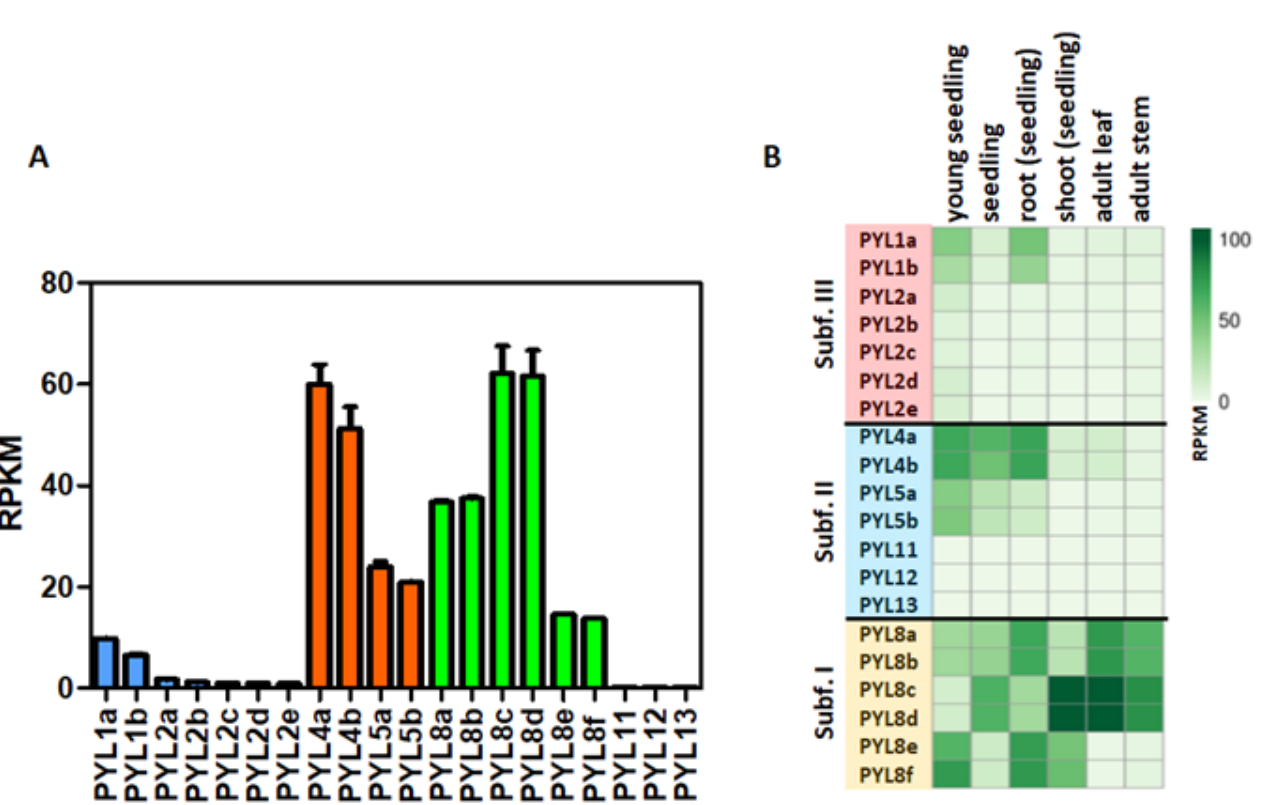
Figure 4. Gene structure of PYL genes in quinoa. The yellow and blue rectangles represent the CDSs and UTRs, respectively, and the black lines represents introns. The lengths of the CDSs, UTRs and introns for each PYL gene are shown proportionally. Orange, blue and red clades represent subfamilies I, II and III, respectively.